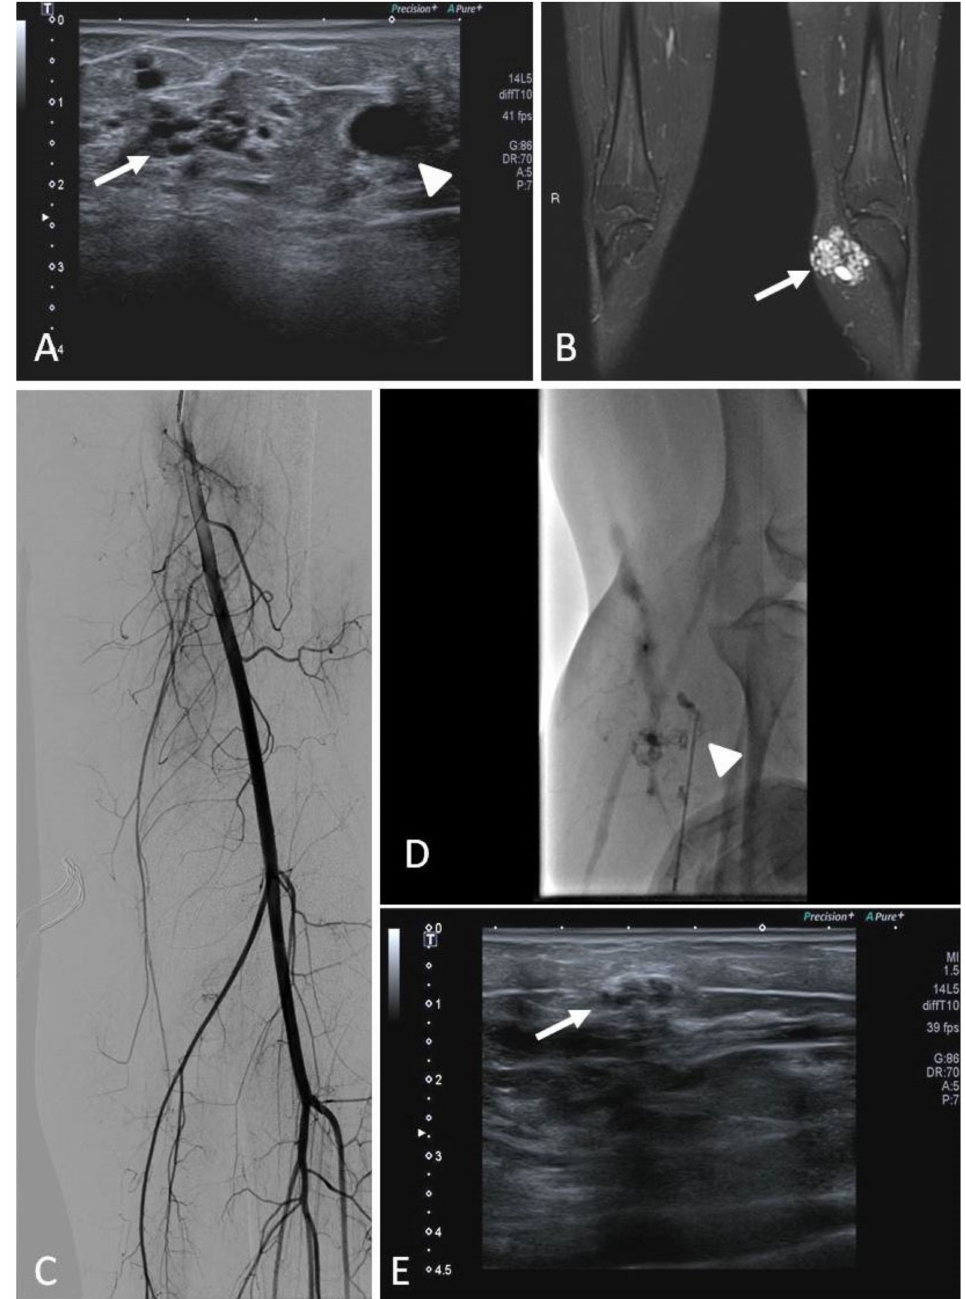
Figure 6. Percutaneous sclero-embolization of a simple low-flow vascular malformation of the leg in a 13-year-old female. ( A ) B-mode Ultrasound (US) image shows a tangle of subcutaneous varicose vessels (arrow) draining into a dilated great saphenous vein (arrowhead). ( B ) Coronal T2-weighted Magnetic Resonance image shows an hyperintense mass (arrow) consistent with a vascular malformation. ( C ) DSA of the femoral axis demonstrates the low-flow nature of the lesion that has no significant arterial feeders. ( D ) Fluoroscopic image acquired during US-guided fine needle (arrowhead) puncture of the dilated vessels shows the distribution of the injected mixture of detergent sclerosant and ethiodized oil (to convey radiopacity); a tourniquet was tied on the thigh (not shown) to stop the saphenous flow and prevent pulmonary embolism. ( E ) B-mode US image shows post-procedural hyperechoic appearance with acoustic shadow of the sclerosed veins